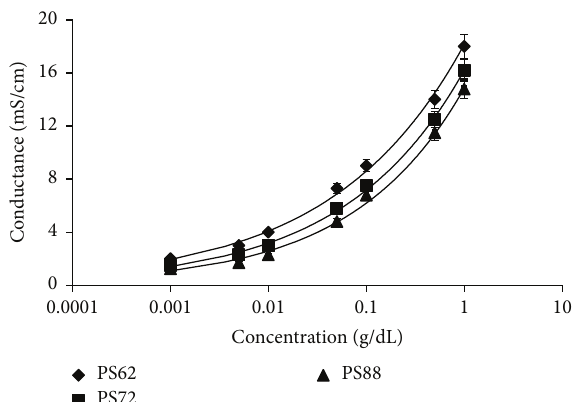
Figure 12: Reduced conductance of various polymer samples as a function of